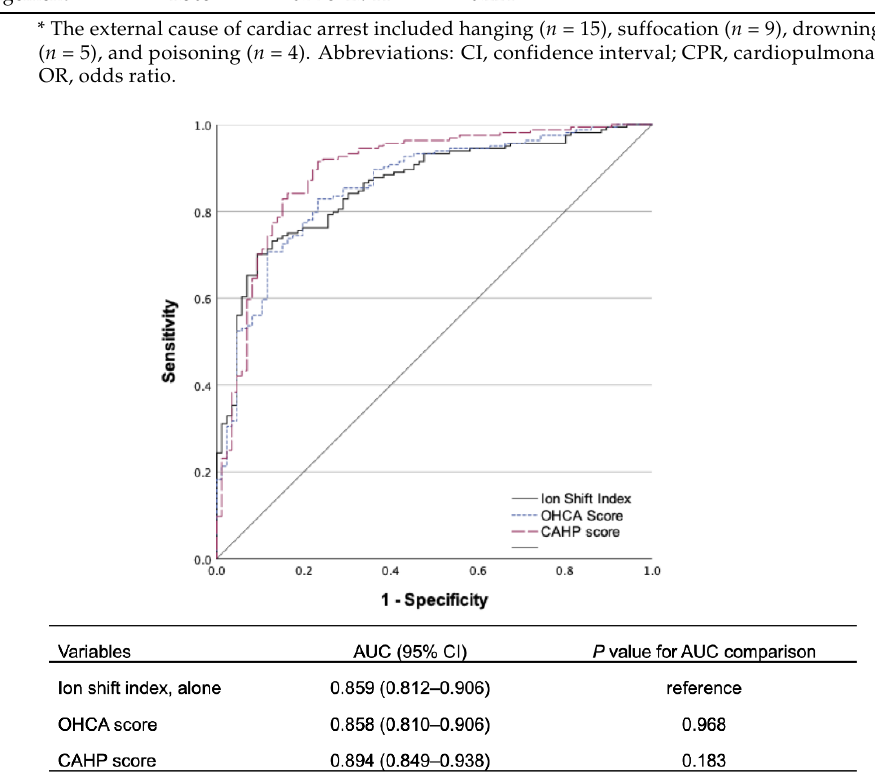
Figure 2. Comparison of the prognostic performances of ion shift index, out-of-hospital cardiac arrest (OHCA), and Cardiac Arrest Hospital Prognosis (CAHP) scores for predicting a poor neurological outcome at 6 months. Abbreviations: AUC, area under the curve; CI, confidence interval. The optimal cutoff value for ISI, based on the Youden index, was 4.25, with a 70.1% sensitivity and a 90.7% specificity (Table 3). An ISI-value of >6.40 predicted a poor neuro- logical outcome at 6 months with a 0% false positive rate and a 24.4% sensitivity. Table 3. Ion Shift Index cutoff values in predicting a poor neurological outcome at 6 months. Type